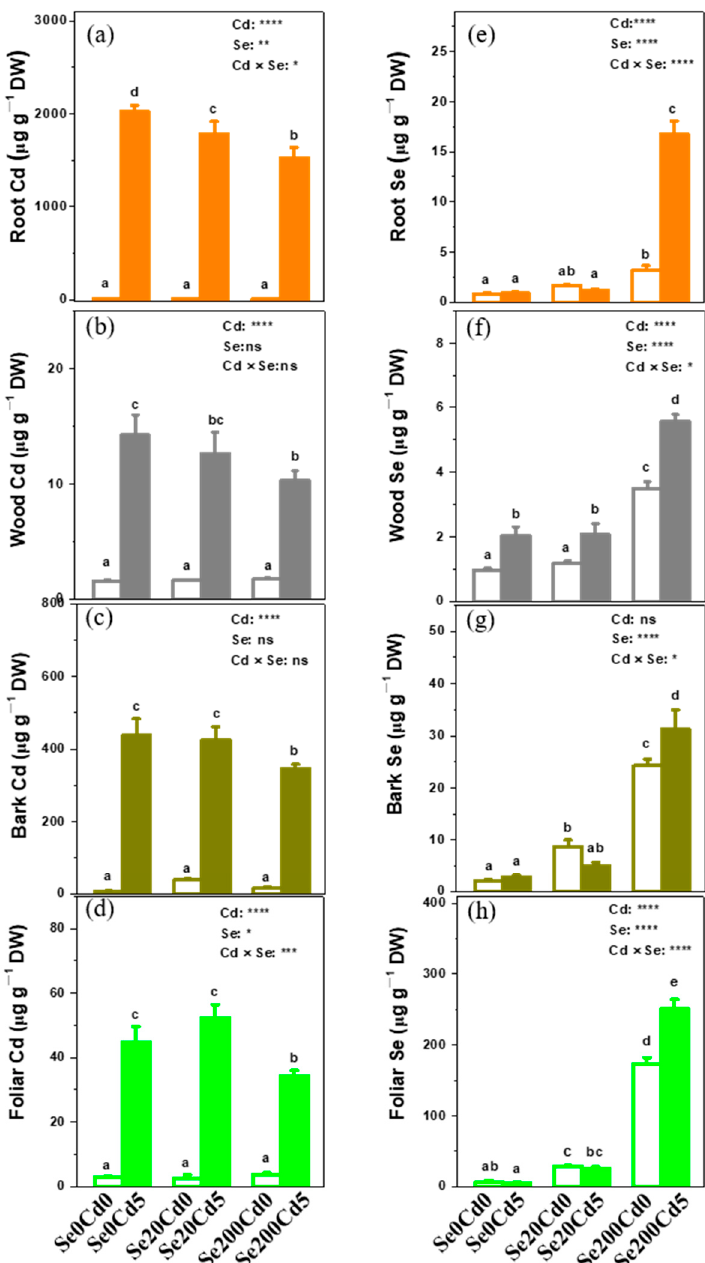
Figure 1. The Cd ( a – d ) and Se ( e – h ) concentrations in the roots, wood, bark, and leaves of J. regia (variety Xinfeng) exposed to either 0 (Cd0) or 5 mM (Cd5) Cd together with one of three Se levels (0 (Se0), 20 (Se20), or 200 (Se200) µ M Se). Data were means ± SE (n = 6). Different lowercase letters on the bars indicate significant difference at p < 0.05 (F-test). p -values of the ANOVAs for Cd, Se, and their interaction (Cd × Se) are also indicated. *, p < 0.05; **, p < 0.01; ***, p < 0.001; ****, p < 0.0001; and ns, insignificant.